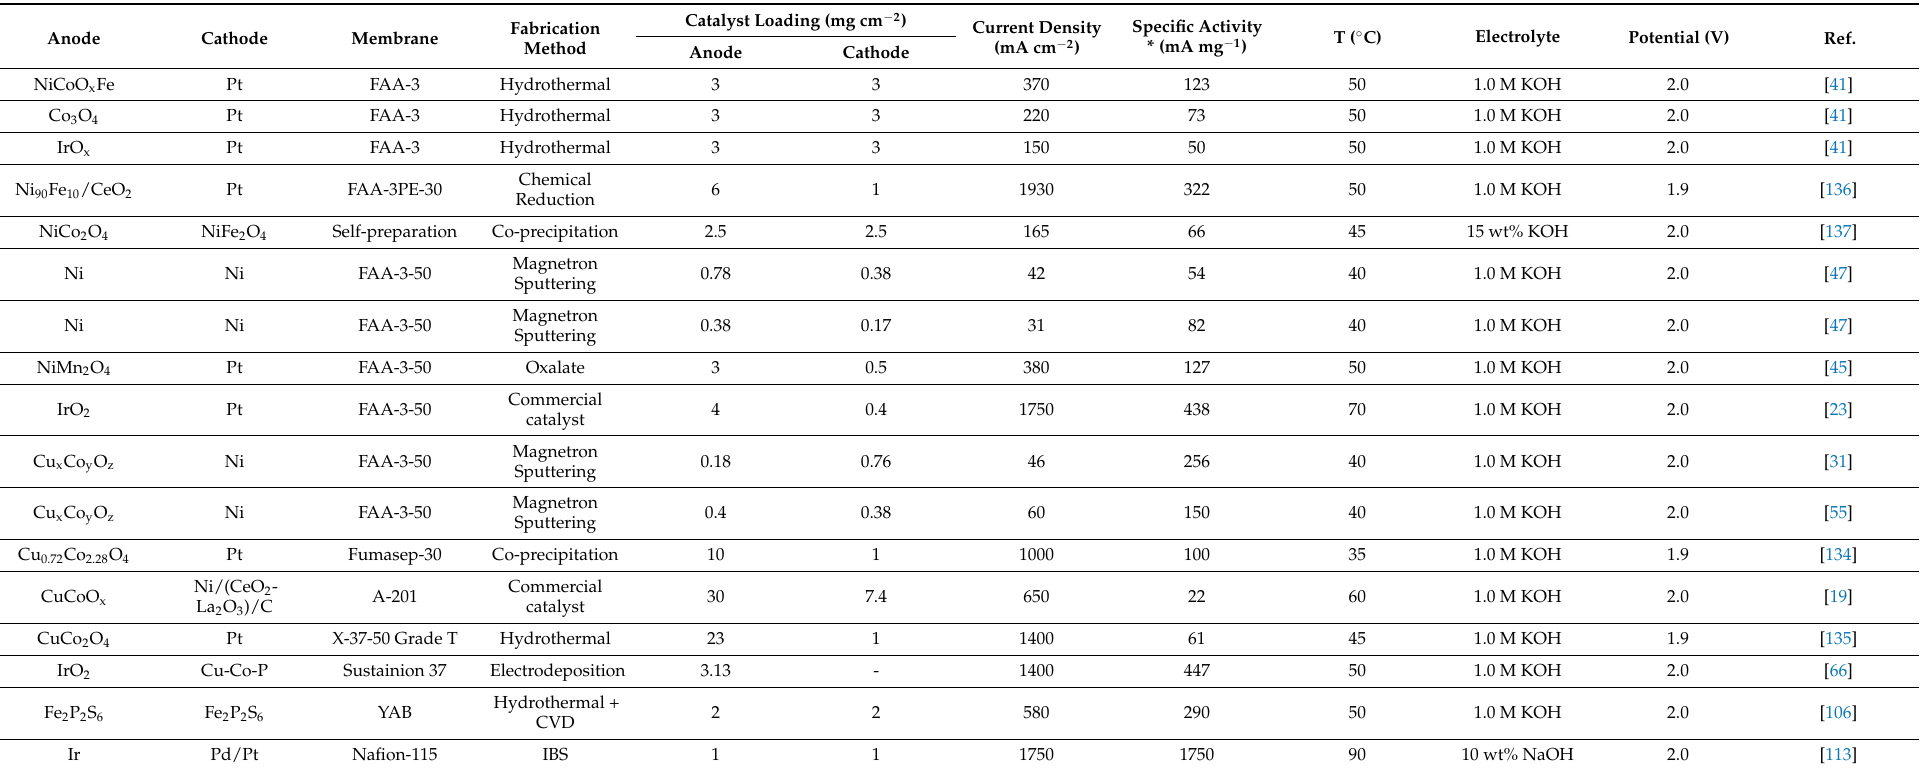
Table 2. A comparison of some of the most relevant studies of